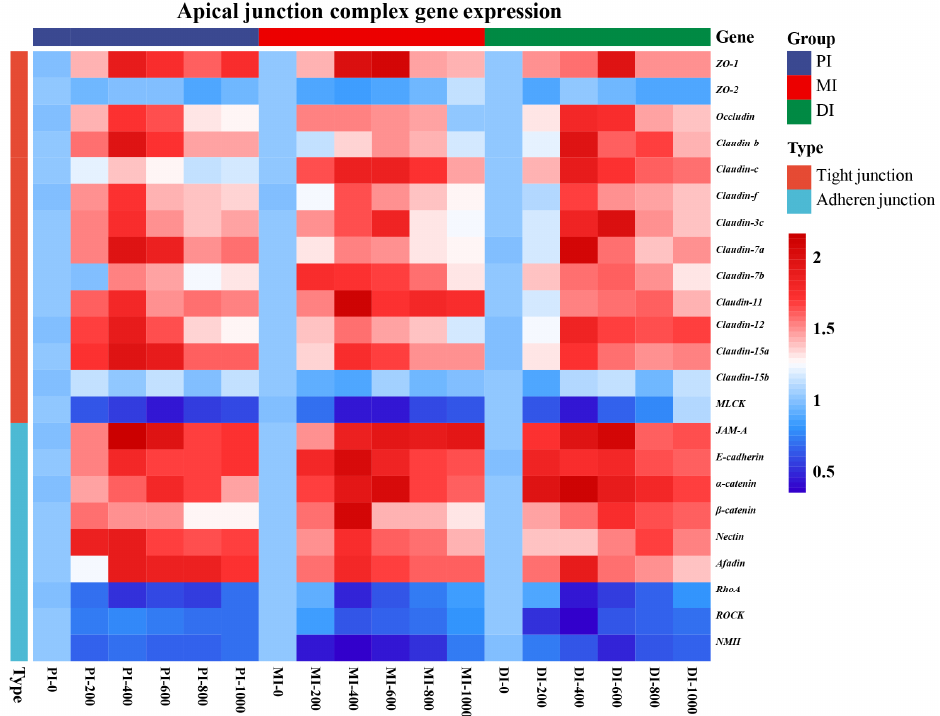
Figure 4. Heat map showing MOS (mg/kg diet) changed expression of AJCs and related signalling molecules genes in three intestinal segments of grass carp after infection with Aeromonas hydrophila . The signal values of up-regulation (red) and down-regulation (blue) were expressed and ranged from 0.5 to 2 fold. Data represent means of six fish in each group (N = 6).